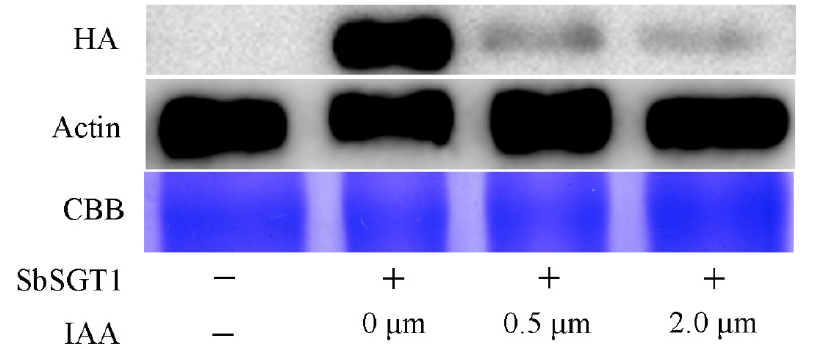
Figure 4. Effects of auxin on the accumulation of SbSGT1 protein level. HA: Specific antibody for the detection of SbSGT1 protein in Nicotiana benthamiana ; Actin: plant reference protein; CBB: Coomassie brilliant blue staining; − : empty control; +: spray IAA with 0–2.0 µM after Agrobacterium tumefaciens harboring pYBA-1143-SbSGT1 infiltration in N. benthamiana .